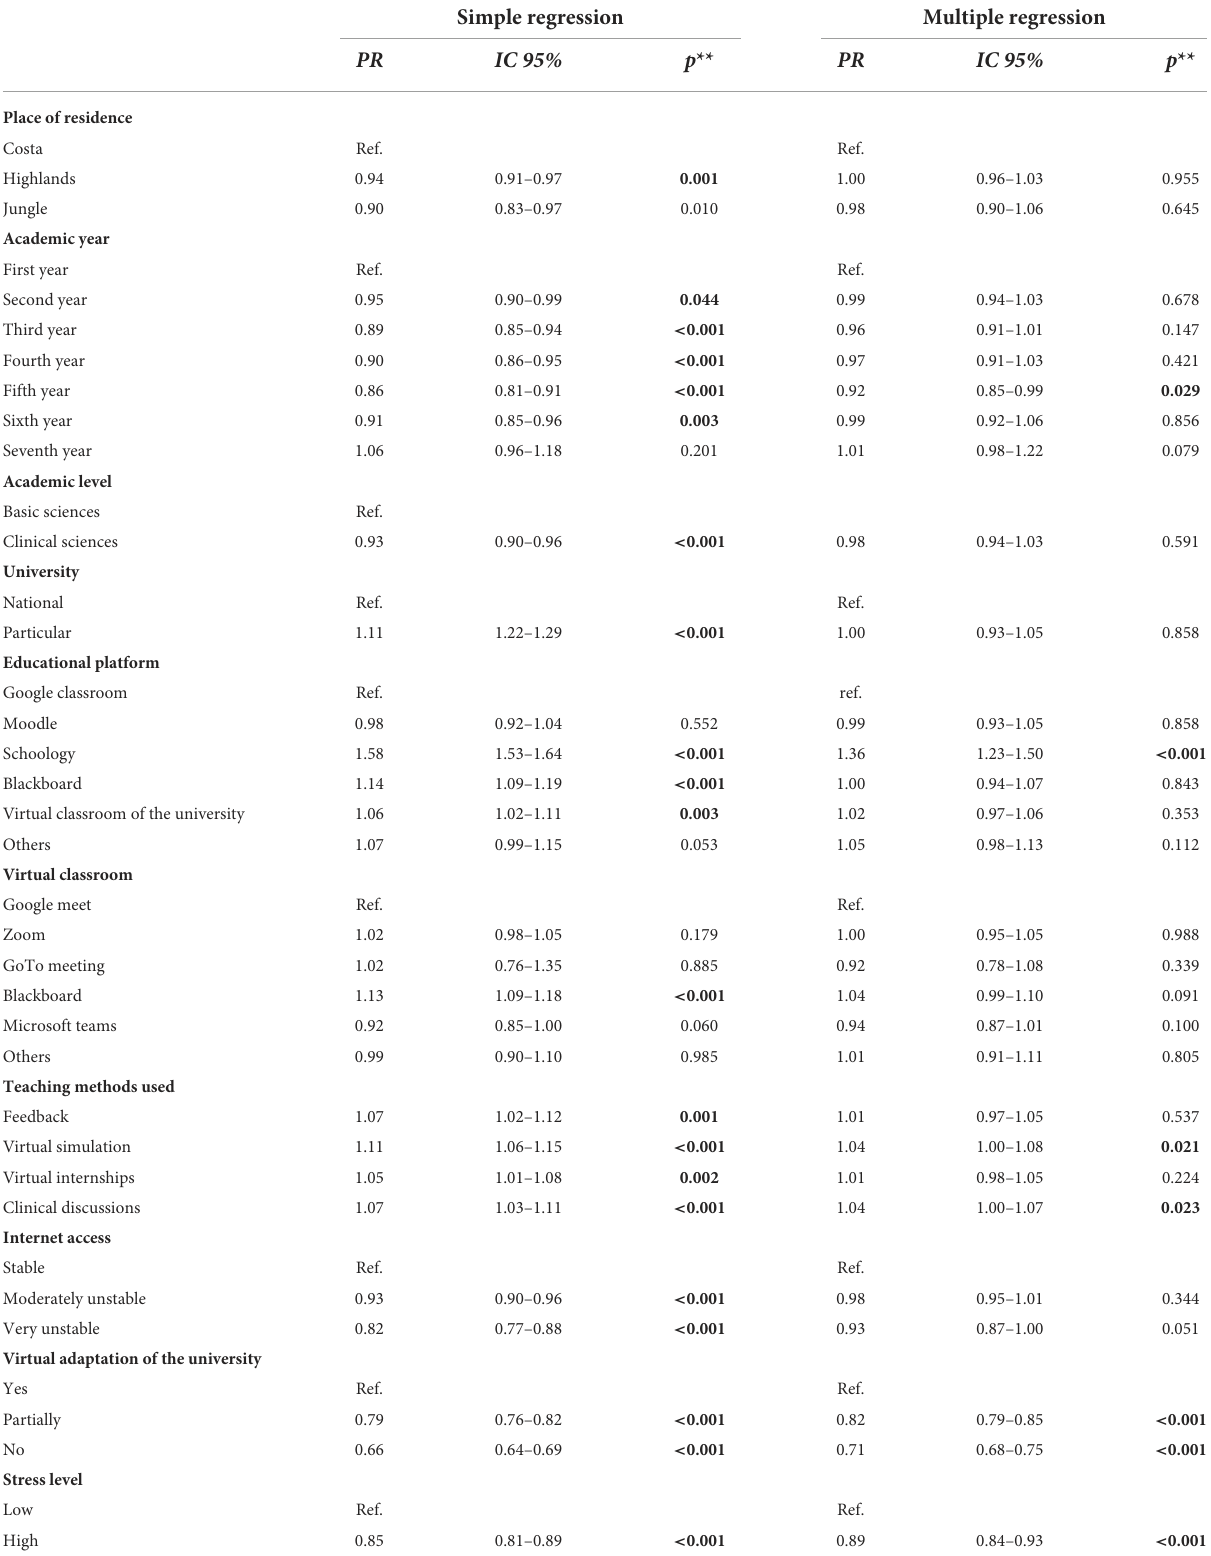
TABLE 3 Factors associated with the level of satisfaction with virtual education (multivariate